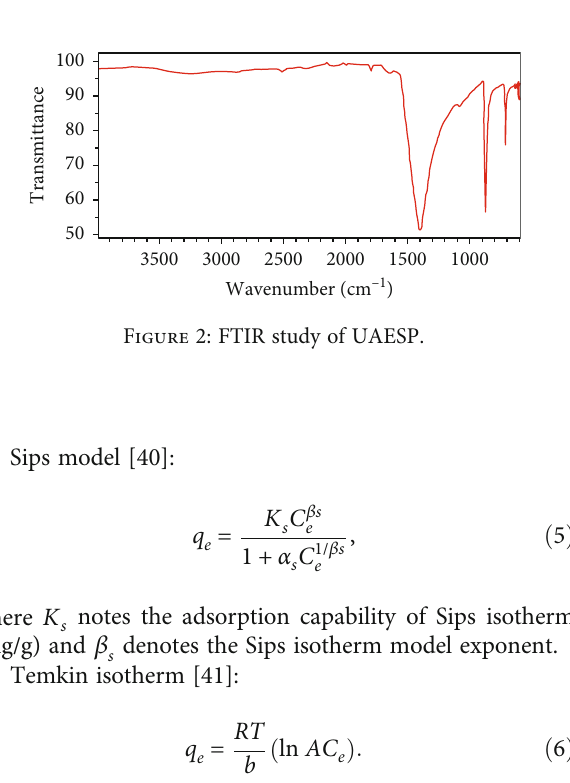
Figure 1: Schematic diagram for the preparation of UAESP.